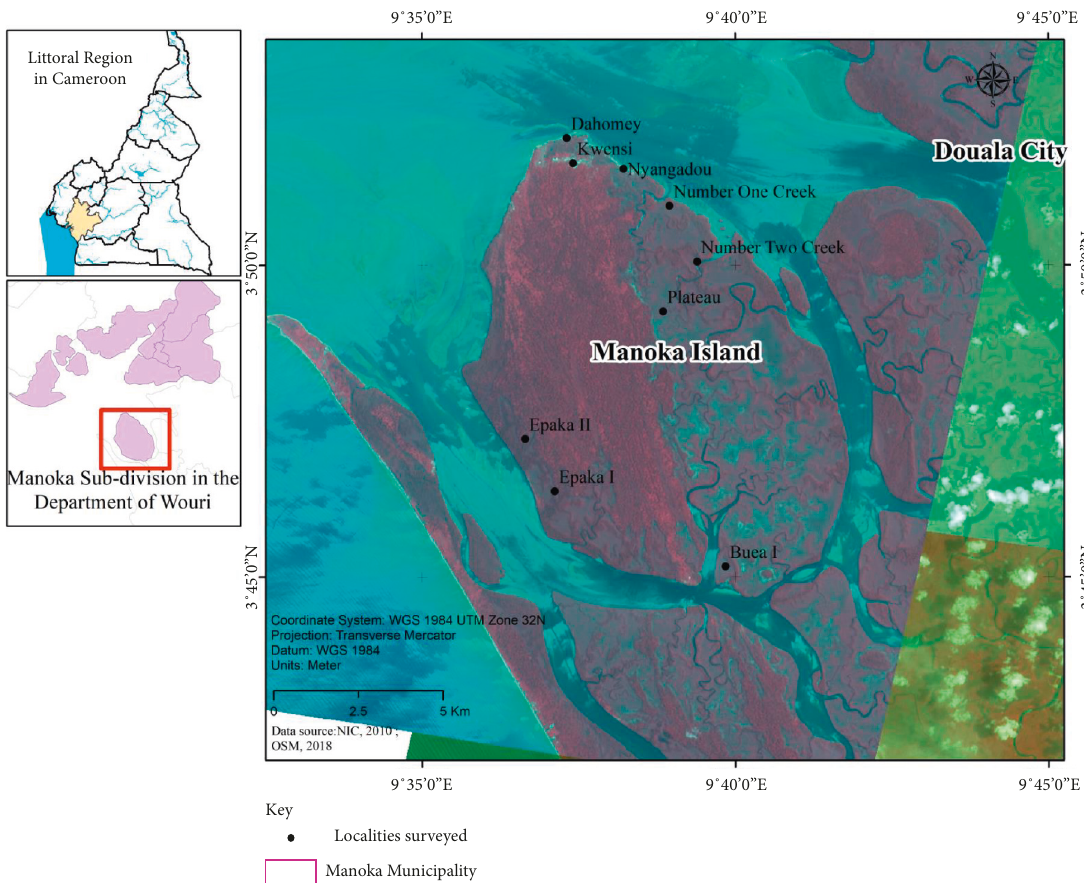
Figure 1: Location of Manoka Island and study